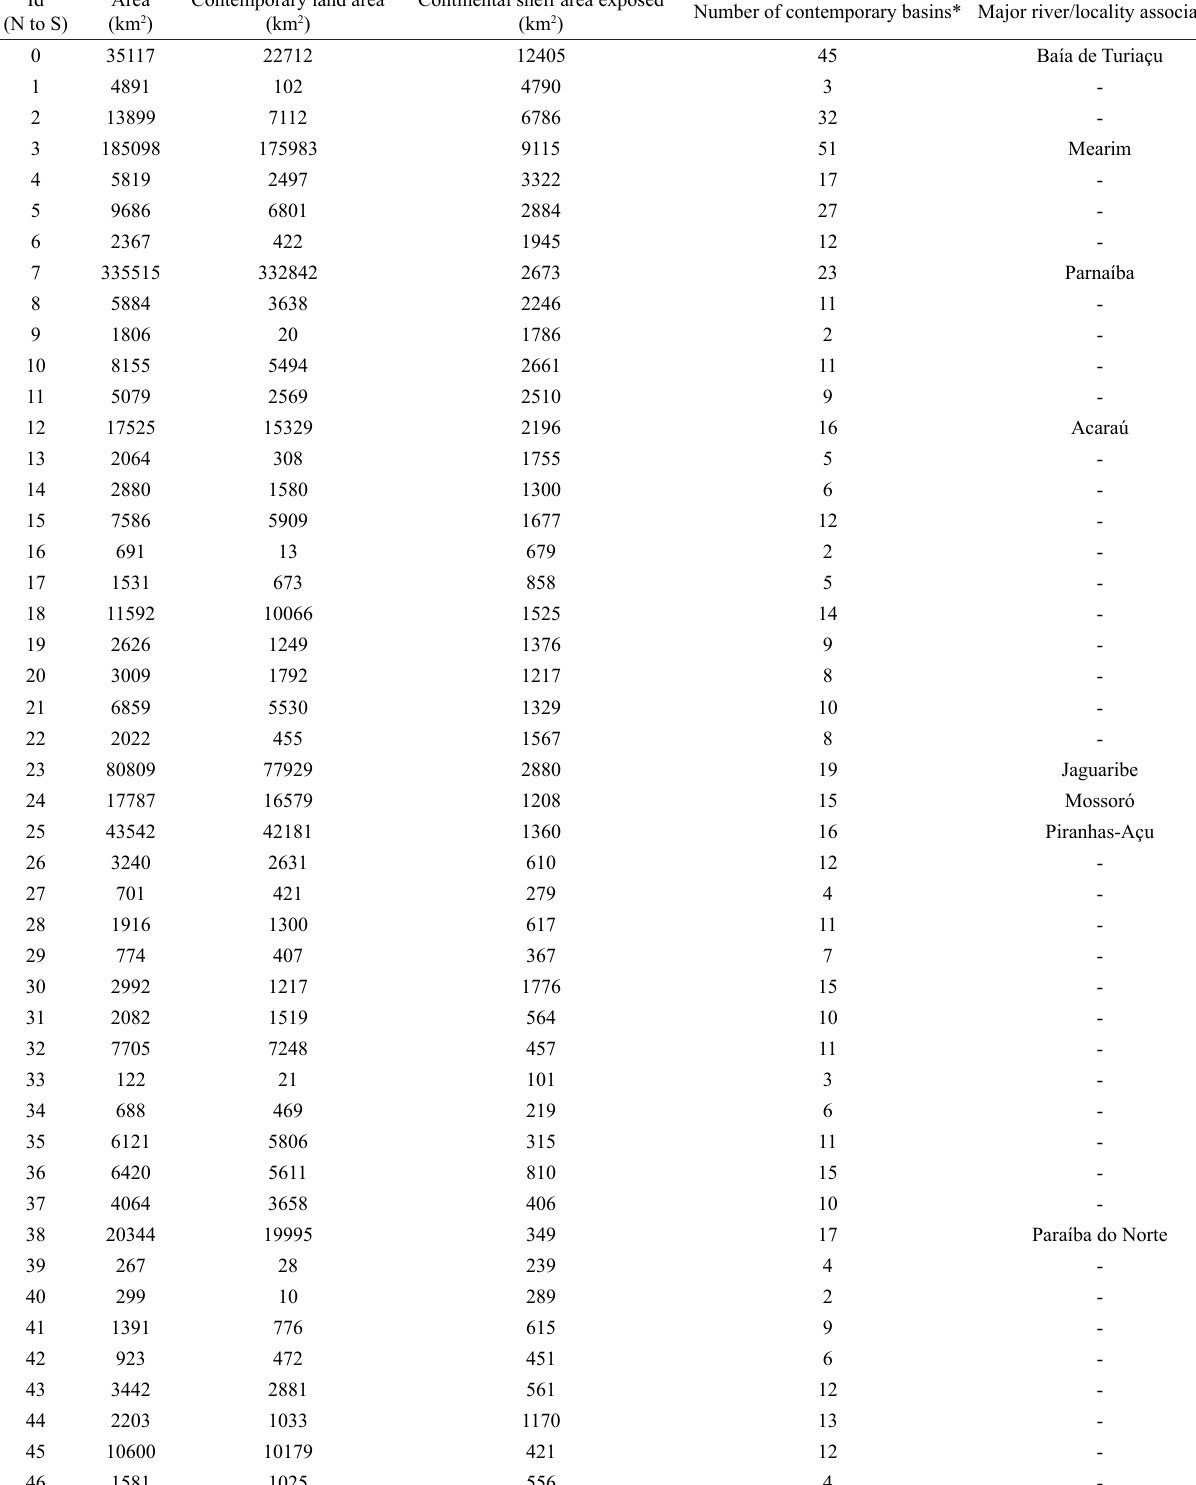
Tab. 1. Properties calculated for each of the 145 inferred paleodrainages arranged north to south (see Fig. 3 for relative posi - tions along coastline), which includes total paleodrainage area, the contemporary land area encompassed by each paleodrai- nage, the area of the paleodrainage that was exposed when sea levels dropped ( i.e. , the corresponding areas of the continental shelf that are submerged today), as well as the number of contemporary basins that was encompassed by each paleodrainage. *Contemporary drainages with areas smaller than 10 km 2 were excluded (see ‘Material and Methods’